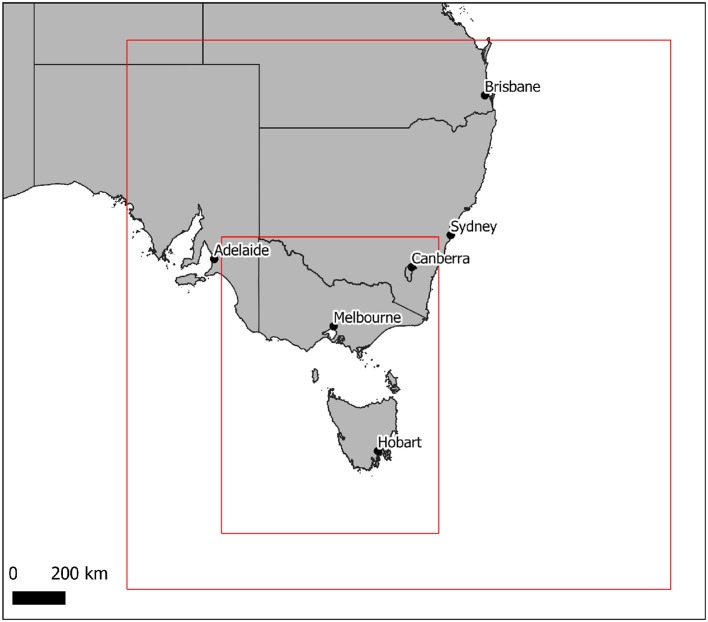
Two domains of the AQFx chemical transport model, with the south-eastern Australia domain run at a 9 km resolution, and the inner Victoria-Tasmania domain run at a 3 km resolution.